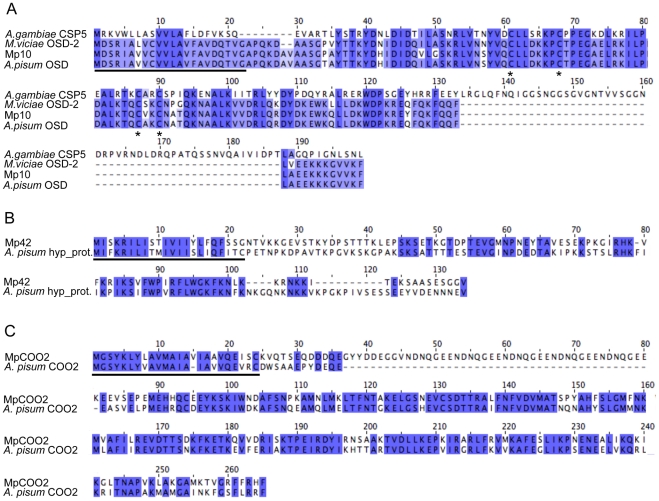
Amino acid alignments of M. persicae effector candidates that alter aphid fecundity.Black lines indicate the predicted signal peptide sequences. (A) Alignment of Mp10 with similar sequences from the aphid species Acyrthosiphon pisum (GenBank accession NP_001119652.1), Megoura viciae (GenBank accession CAG25435.1), and the mosquito species Anopheles gambiae (GenBank accession XP_317401.4). Asterisks indicate conserved cysteine residues. (B) Alignment of Mp42 with a similar sequence from A. pisum (GenBank accession XP_001948510). (C) Alignment of MpC002 with a similar sequence from A. pisum (GenBank accession XP_001948358.1).